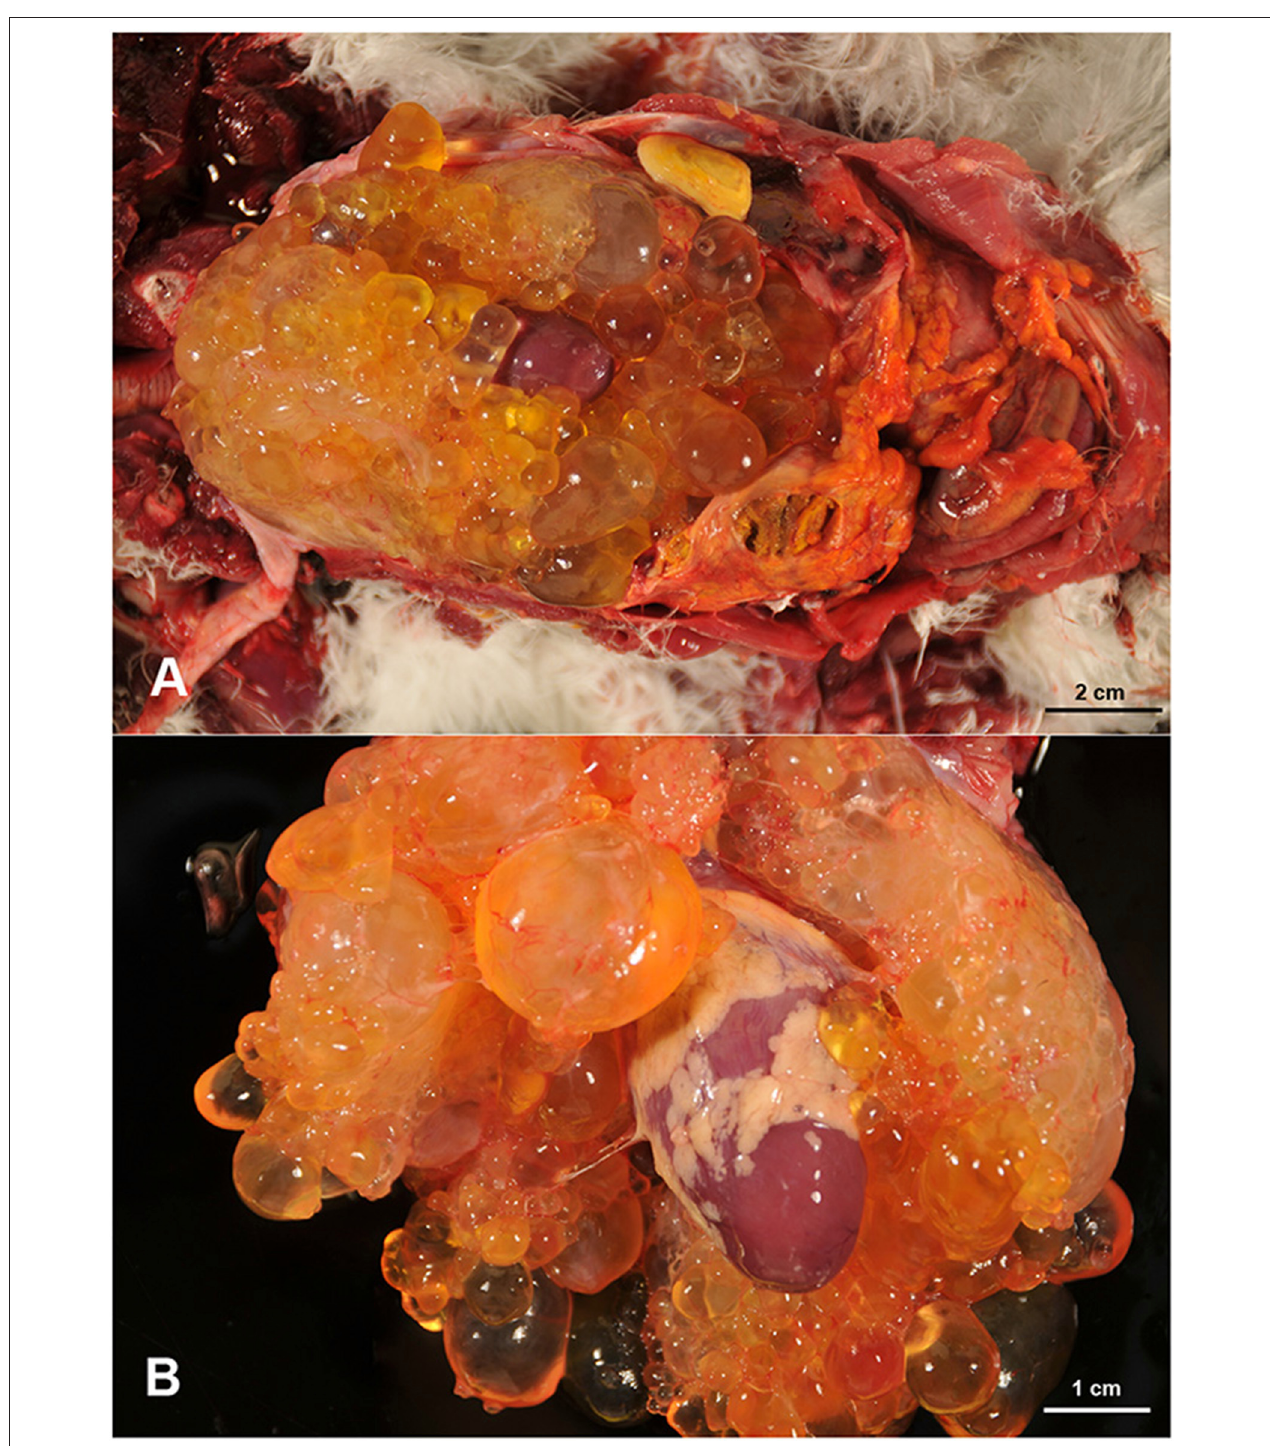
FIGURE 1 | Multiple cystic cavities, filled with a clear fluid, are occupying the thoracic area of the coelomic cavity with presence of free fibrin clots (A) . These cystic structures engulfed the heart and are firmly attached to the epicardium (B) .